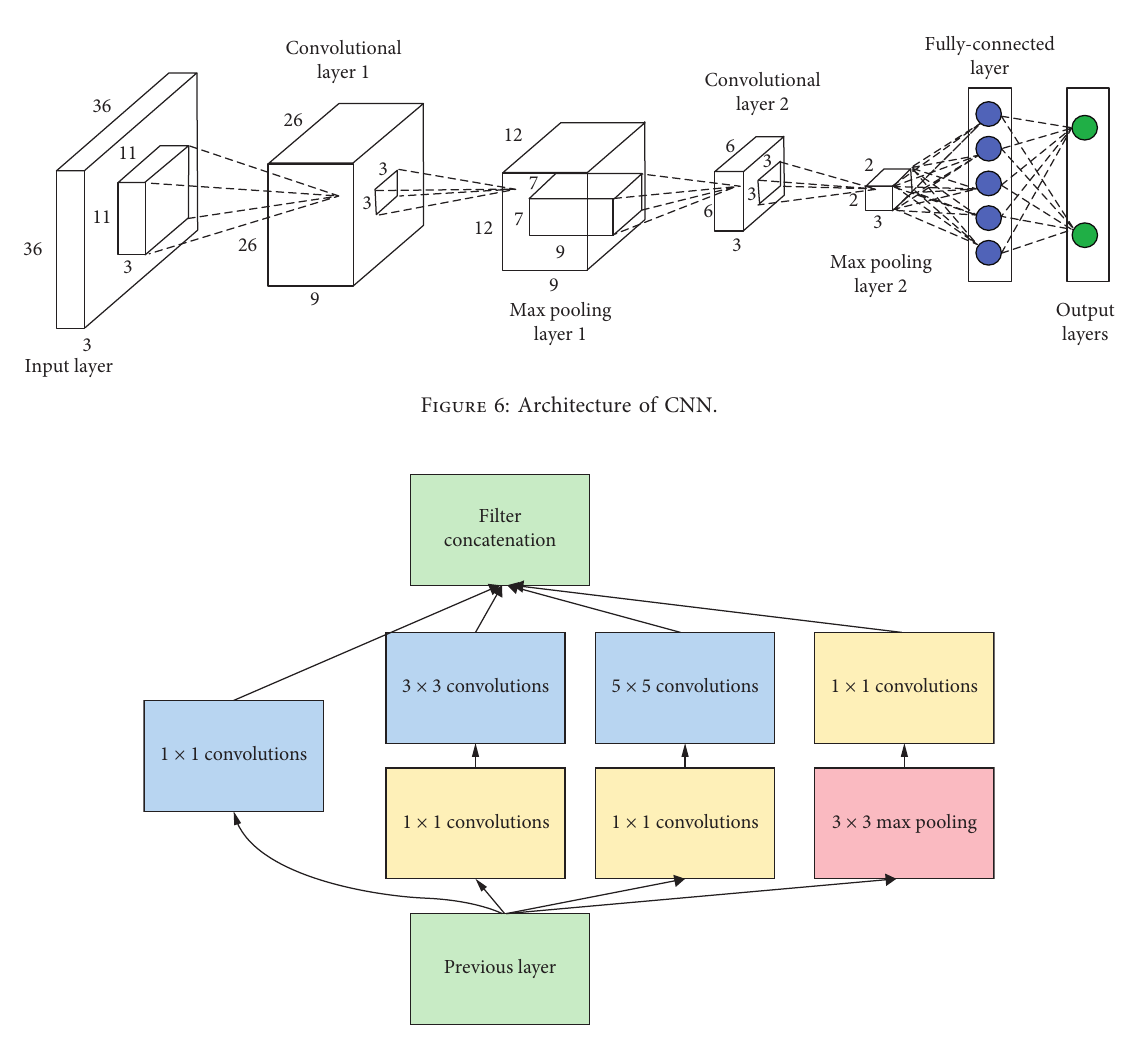
Figure 7: Inception module with dimension reduction. Source: adapted from [34, 35].